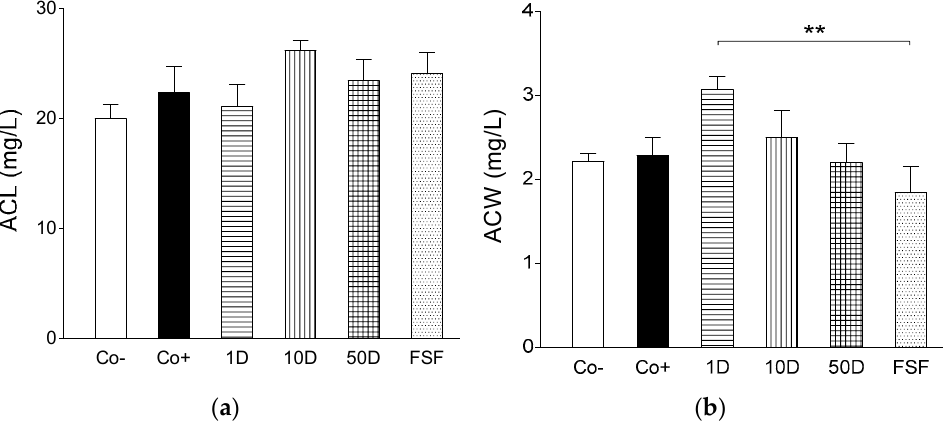
Figure 6. The effect of high-fat, high-sugar diet (HFHSD) (positive control: Co+), 2 g/kg bw/day fenugreek seed flour in addition to HFHSD (FSF), 1, 10 and 50 mg/kg bw/day diosgenin in addition to HFHSD (1D, 10D and 50D, respectively) on the antioxidant capacity of lipid- (ACL; ( a )) and water-soluble (ACW; ( b )) substances of blood in Wistar rats. The negative control group (Co − ) consisted of rats receiving conventional rat food and tap water. The columns show the average values of the given groups (+SEM). Asterisks denote the significance level of differences between groups (**: p < 0.01).